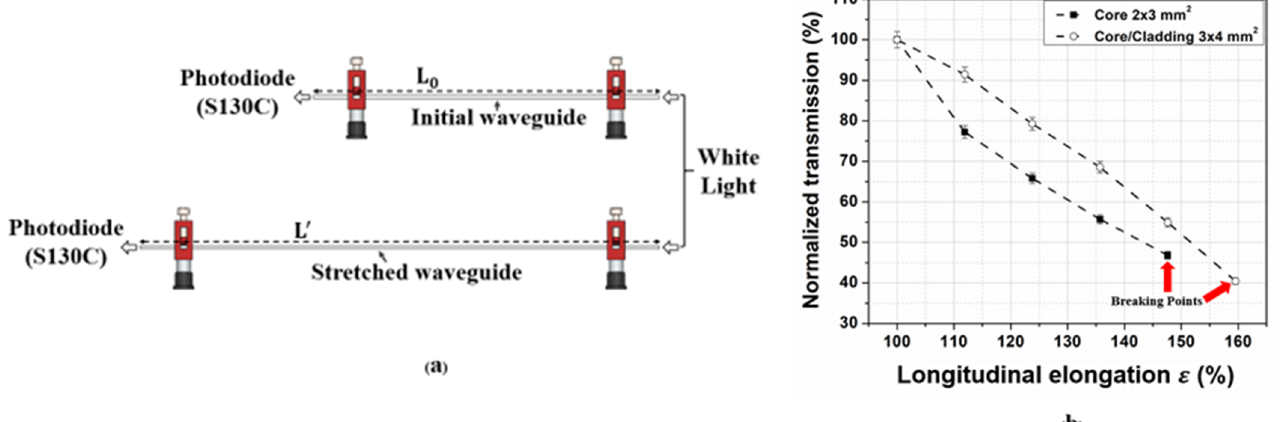
Figure 7. ( a ) Longitudinal elongation process. ( b ) Normalized transmission as a function of longitudinal elongation.